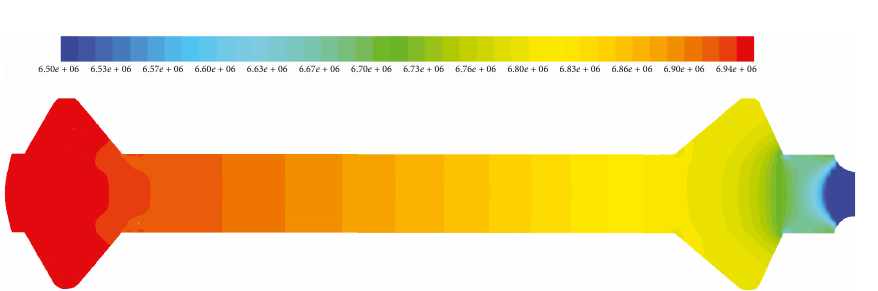
Figure 4: The grain of the sample SRM.